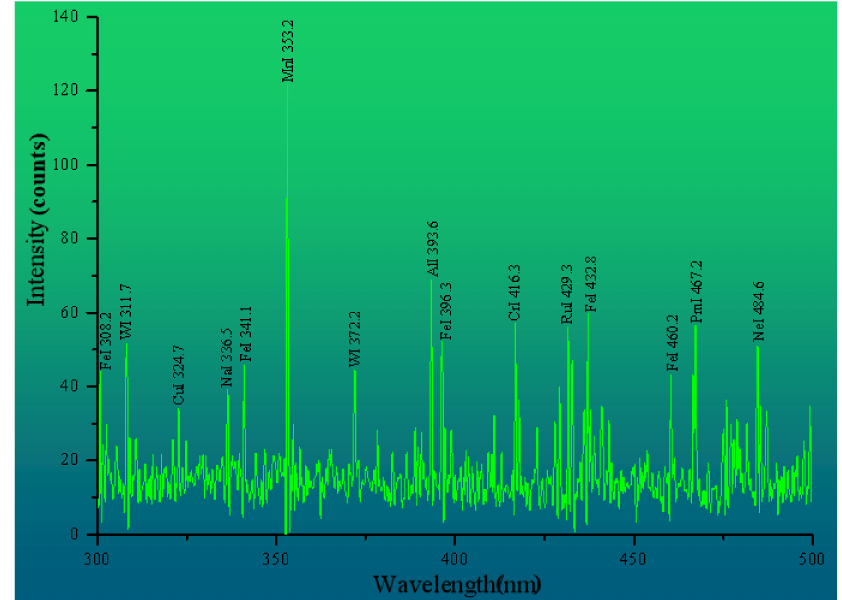
Figure 7. LIBS spectral curve of water sample #16 after